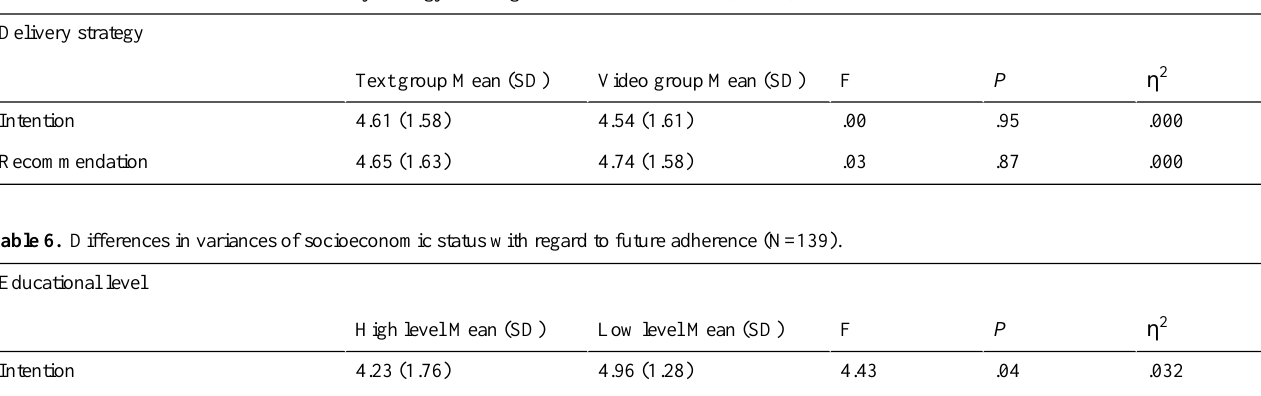
Table 5. Differences in variances of delivery strategy with regard to future adherence (N=139).